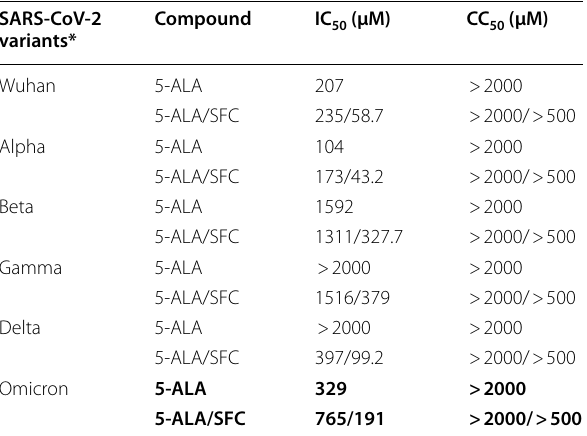
Table 1 IC and CC values of 5-ALA and 5-ALA with SFC 50 50 against SARS-CoV-2 Omicron